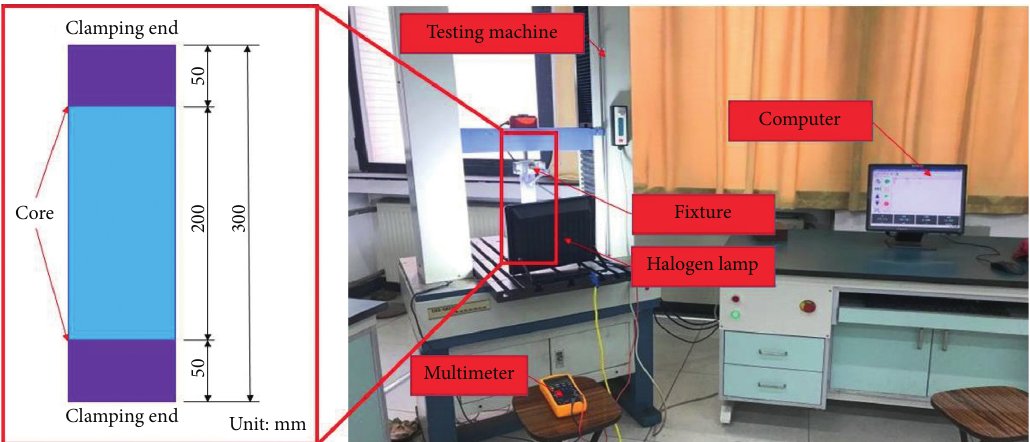
Figure 4: Test site layout.